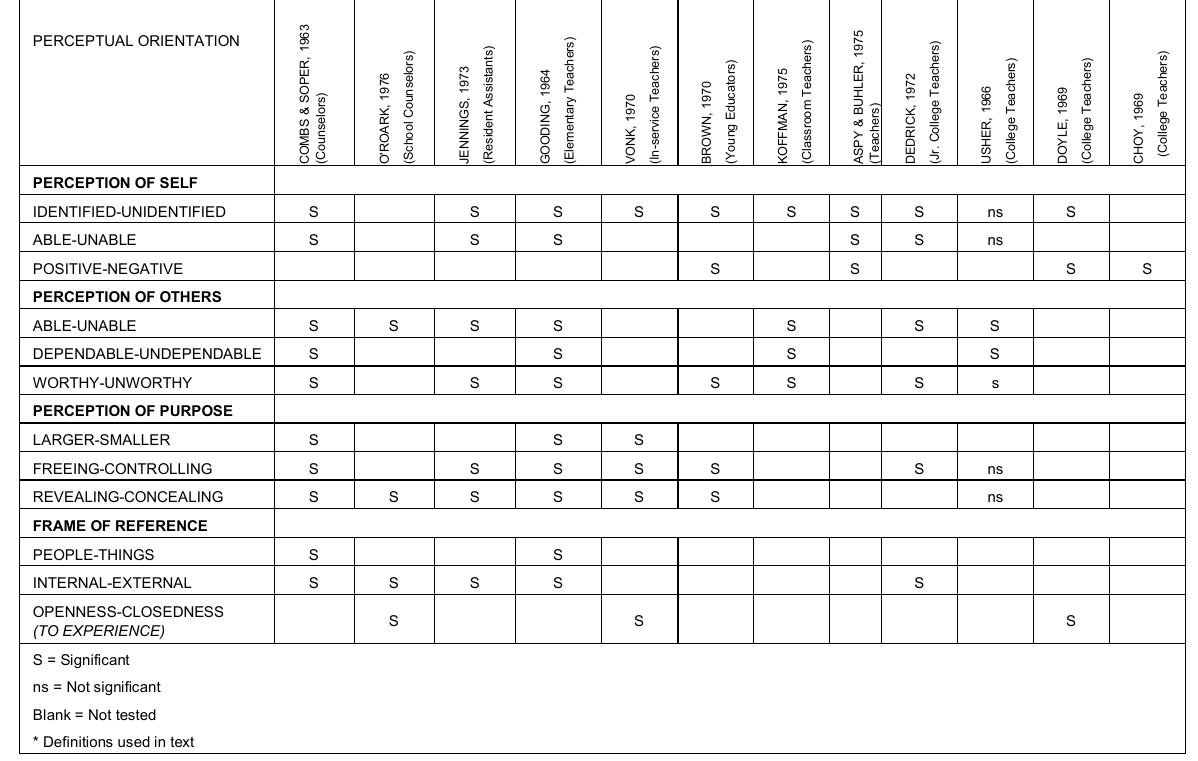
Figure 1. Perceptual (dispositional) Studies: Helper Effectiveness Research from the Florida Studies in the Helping Professions (Combs et al., 1969). Wasicsko (1977b) studied the teachability of the 12 perceptual factors and found that four factors were more rapidly acquired in training sessions. The four factors, one in each area, were: